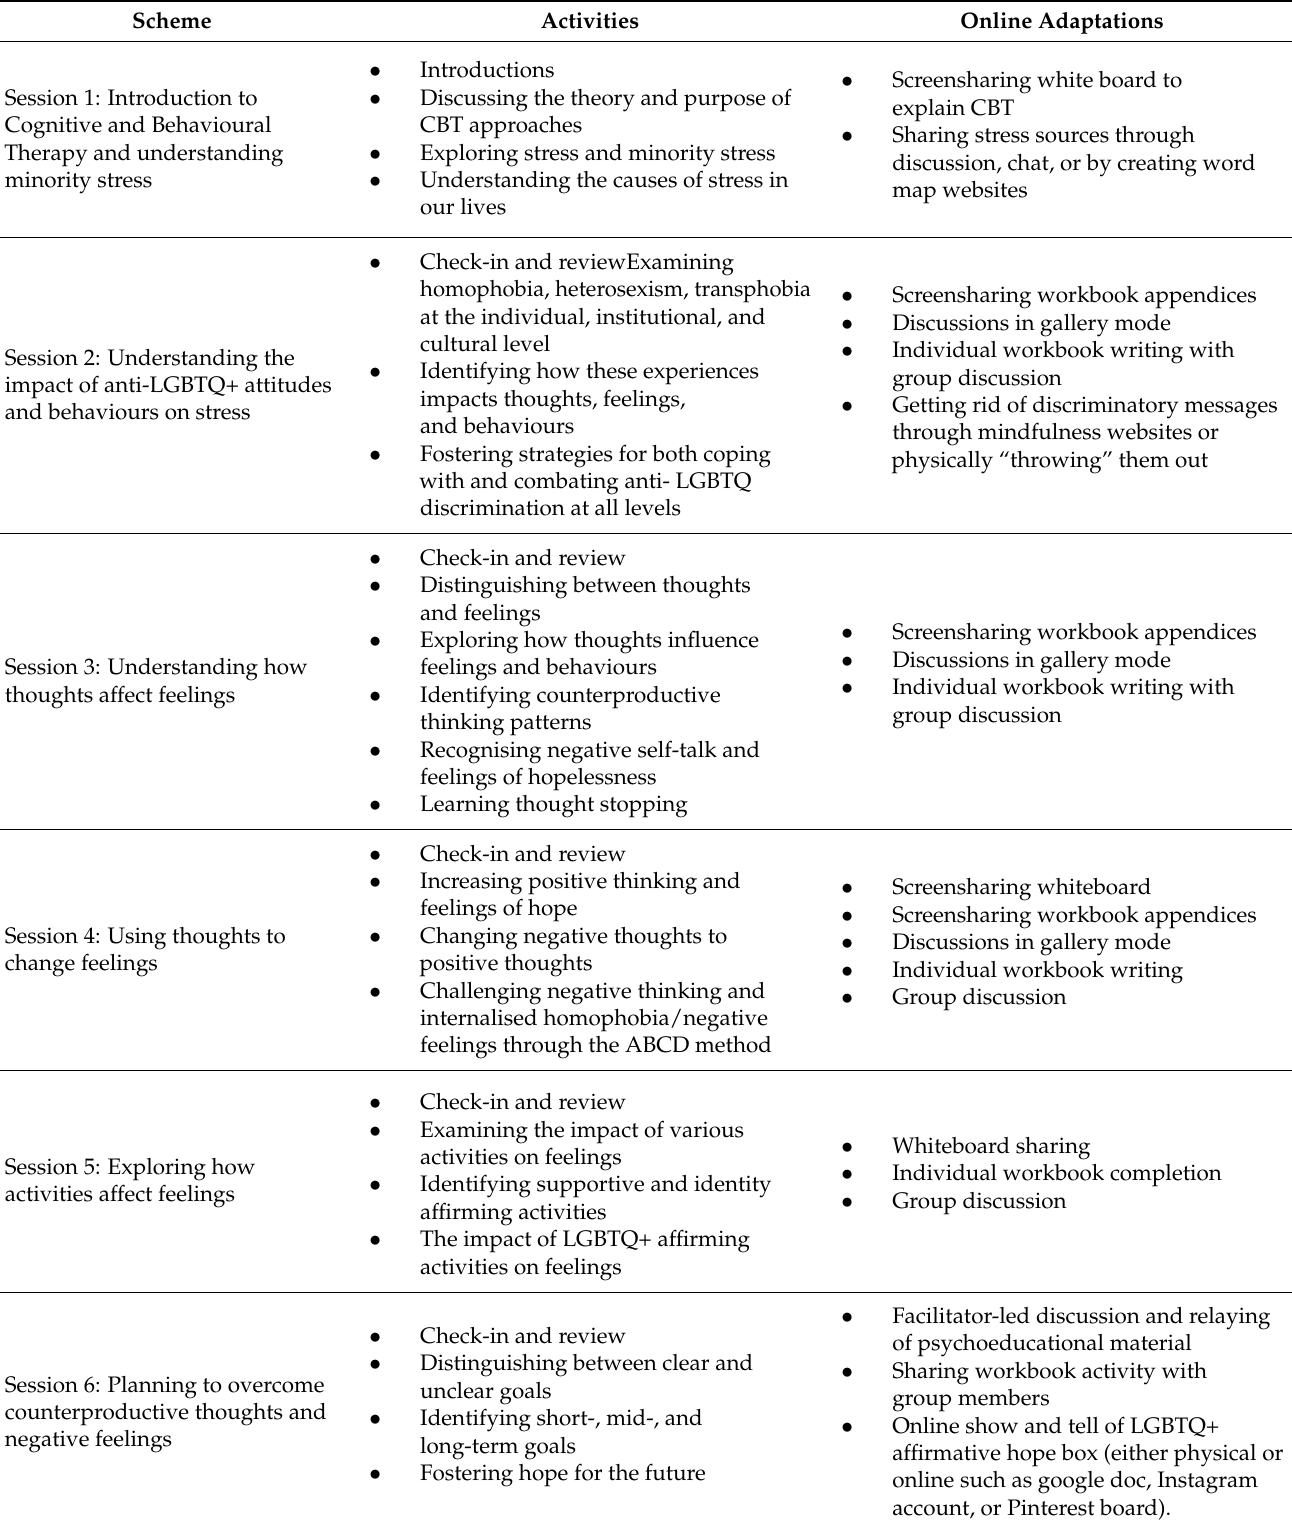
Table 2. AFFIRM curriculum—online facilitation techniques (adapted from Craig and Austin, 2016).